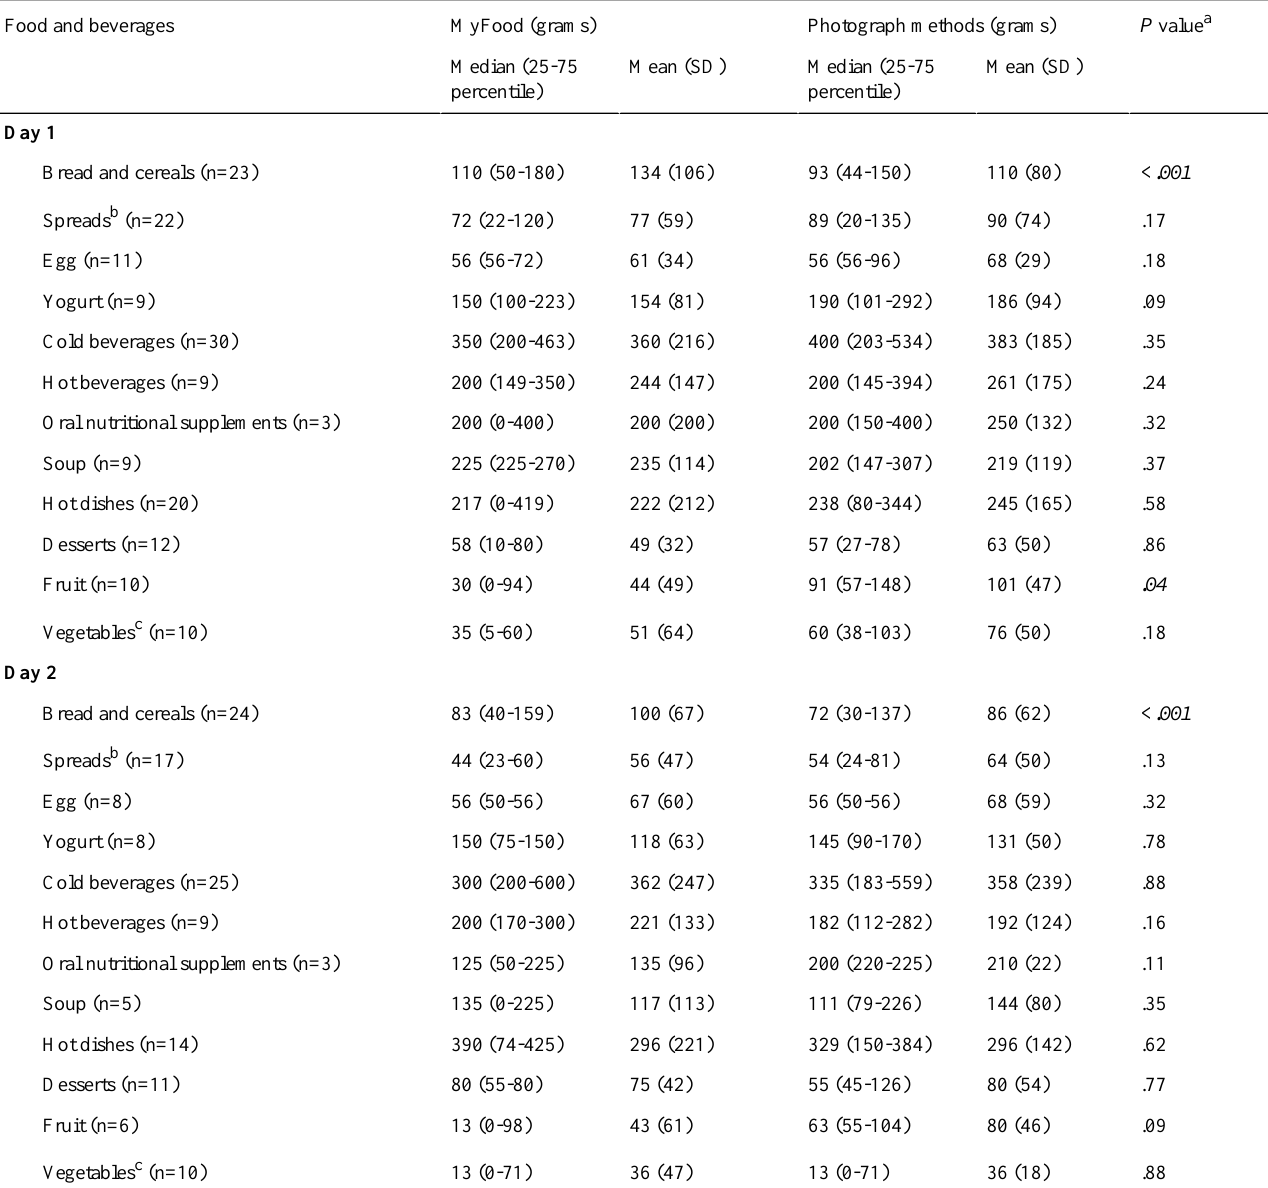
Table 4. Food and beverage intake (grams) recorded in MyFood and estimated in the photograph method. Significant P values (<.05) are in italics.